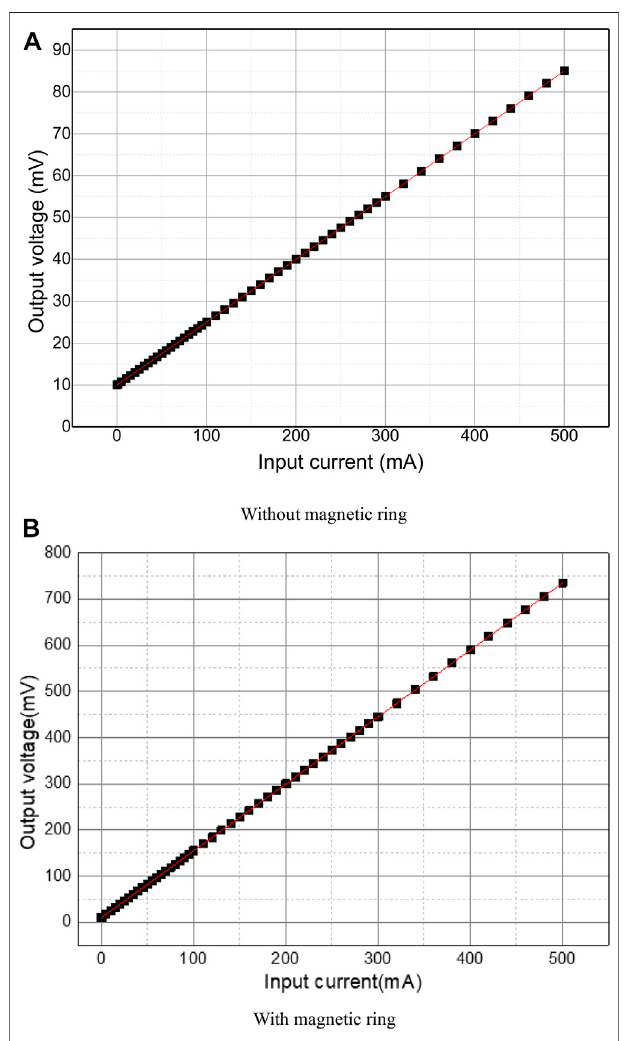
FIGURE 5 | Fitting curve results of magnetic fi eld sensor (A) Without magnetic ring, (B) With magnetic ring.